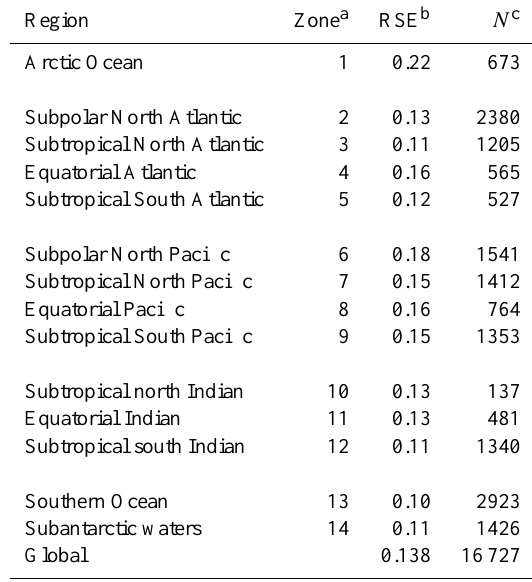
Table 1. Regional and global skill evaluation for predicting (cid:127) Ar (see Fig. S3 for map of spatial